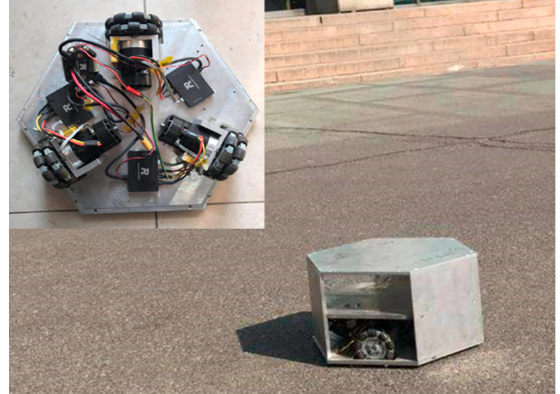
Figure 8. Wheeled robot used to measure the trajectory, and the robot is developed and assembled by laboratory of system engineering in Beijing Institute of Technology, Beijing, China.